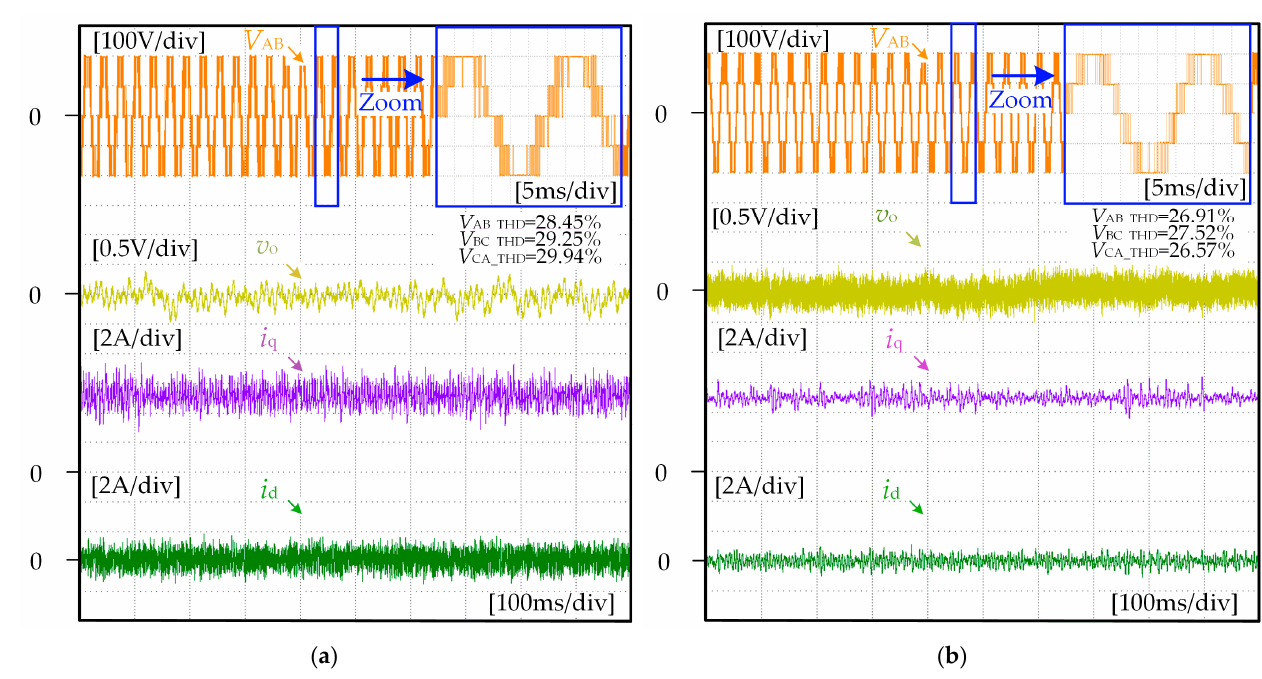
Figure 12. Steady-state performance at 1000 r/min 5 N · m. ( a ) Traditional MPCC strategy; ( b ) Proposing ECS-MPCC